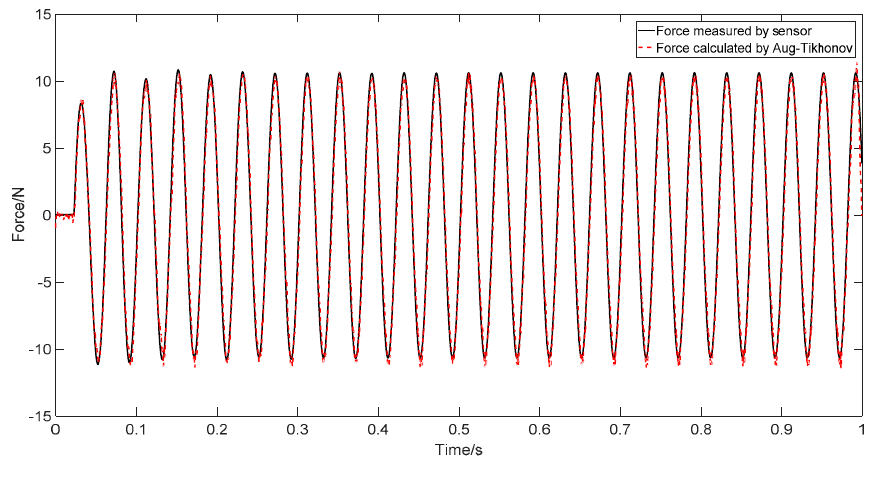
Figure 32. Identification result of sinusoidal load.